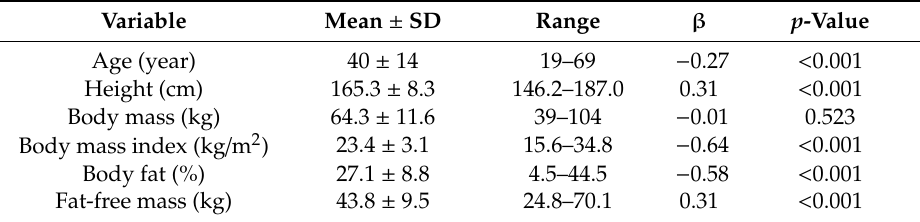
Table 2. Main characteristics of the study participants (N = 1009) and their association with peak oxygen